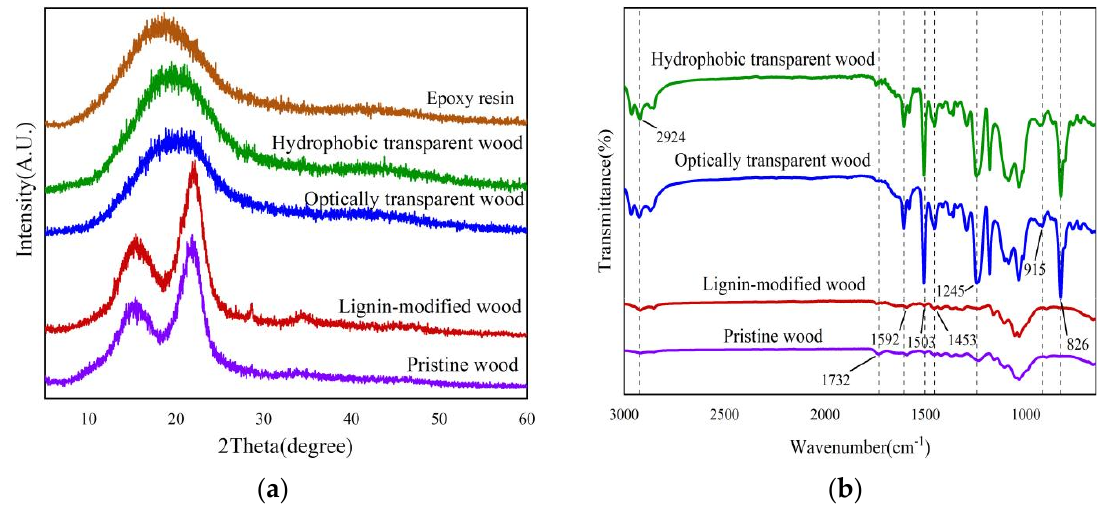
Figure 3. The XRD ( a ) and FT-IR ( b ) pa tt erns of several groups of wood samples.